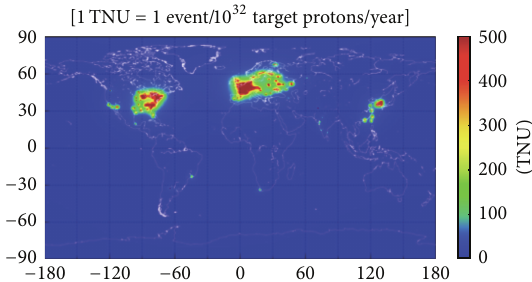
Figure 5: Reactor ] 𝑒 signal (expressed in TNU) in the world as in the middle of 2012, calculated in